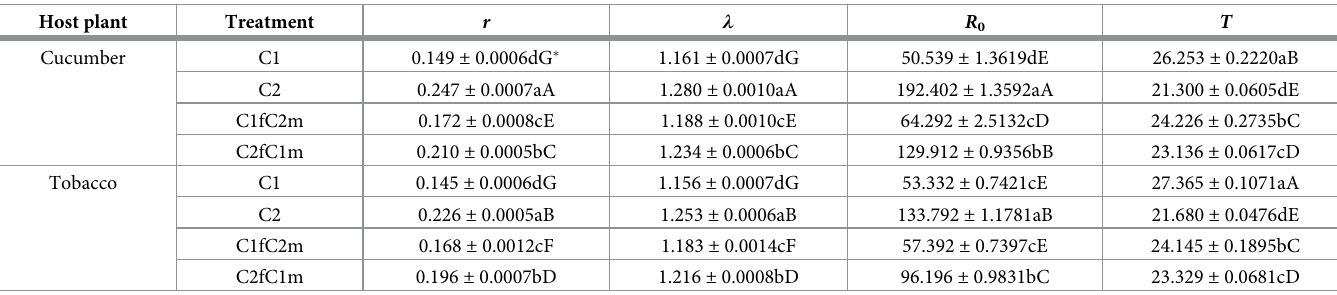
Table 7. Estimates (mean ± S.E.) of life table parameters of B . tabaci . Host